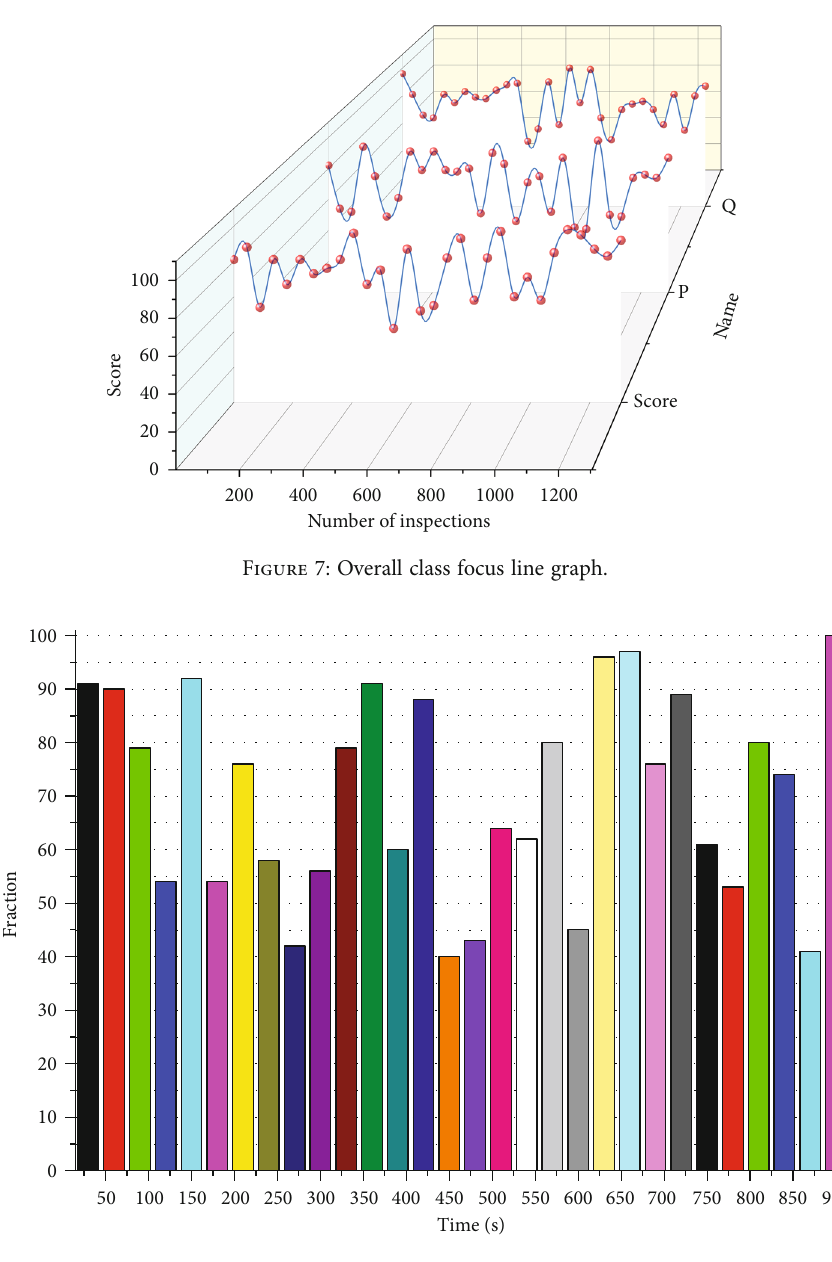
Figure 8: Concentration scores for all